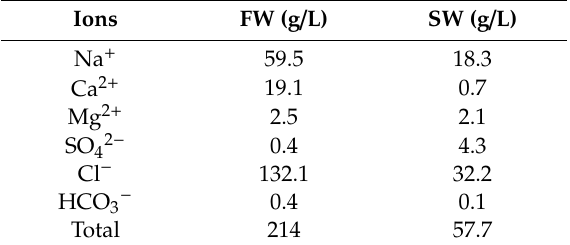
Table 5. The amount of salts in simulated FW and SW.